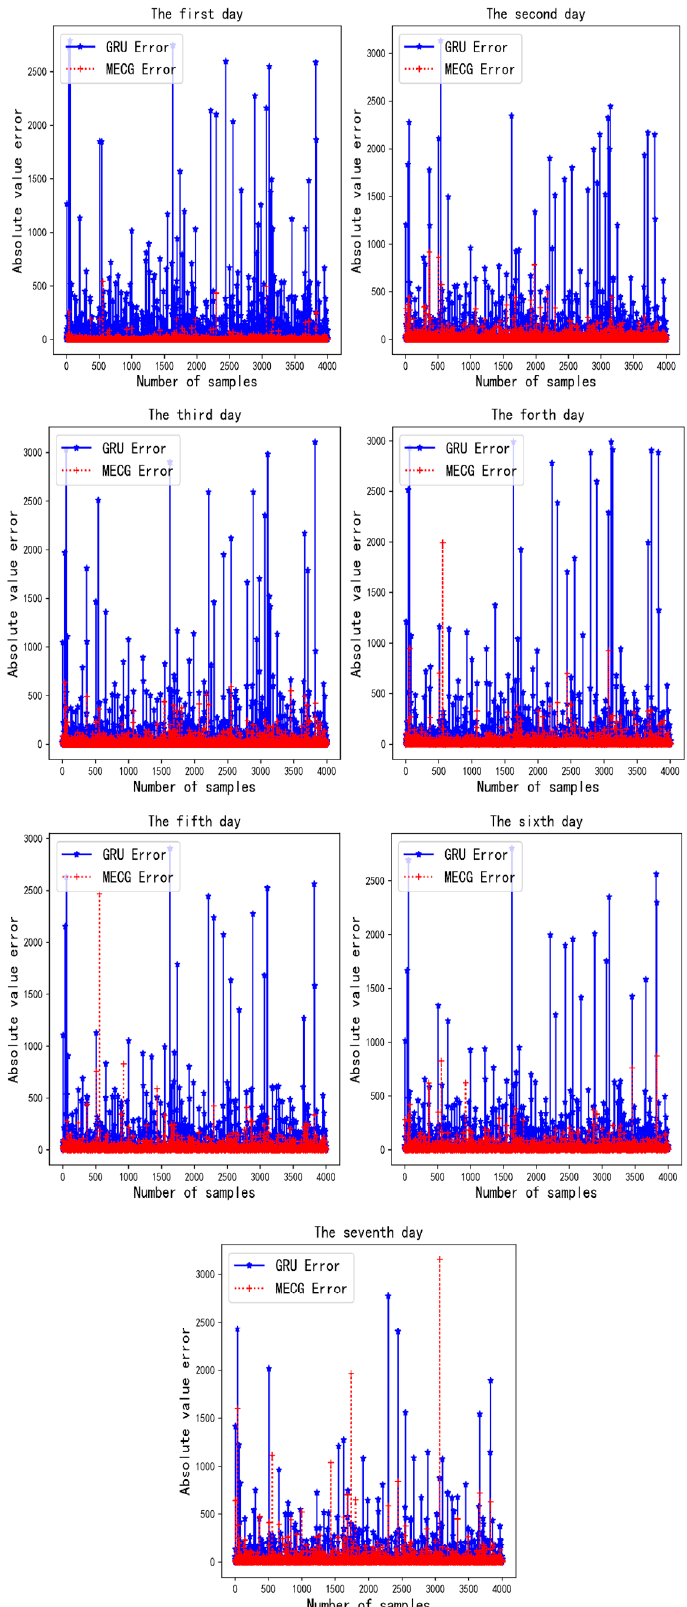
Figure 12. Absolute error values of GRU and MECG for all samples.